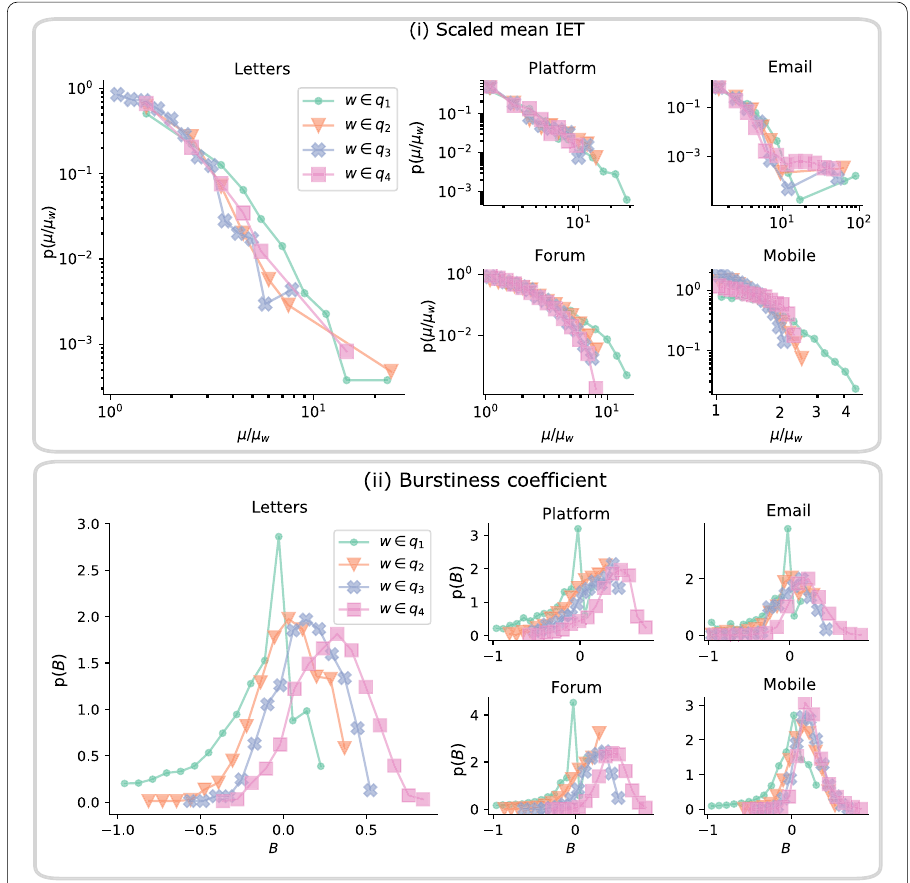
Fig. 4 Distribution of different values derived from the IET distribution for correspSearch and our four reference datasets. The scale is days for correspSearch, and seconds for the rest of the datasets. ( i ) Scaled mean IET µ/µ w , ( ii ) Burstiness coefficient